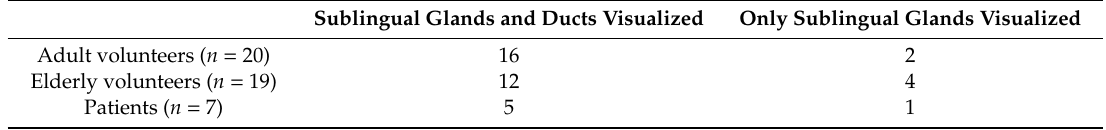
Figure 1. MR sialography of sublingual gland ducts. Extraglandular portions of the typical sublingual gland ducts in MR sialography (( A ): overall image, ( B ): enlarged image of the sublingual gland area) can be identified as many bright, homogeneous, ascending linear structures (arrows) in continuity with the sublingual glands (arrowheads). Table 3. Summary of visualization of sublingual gland ducts by MR sialography.